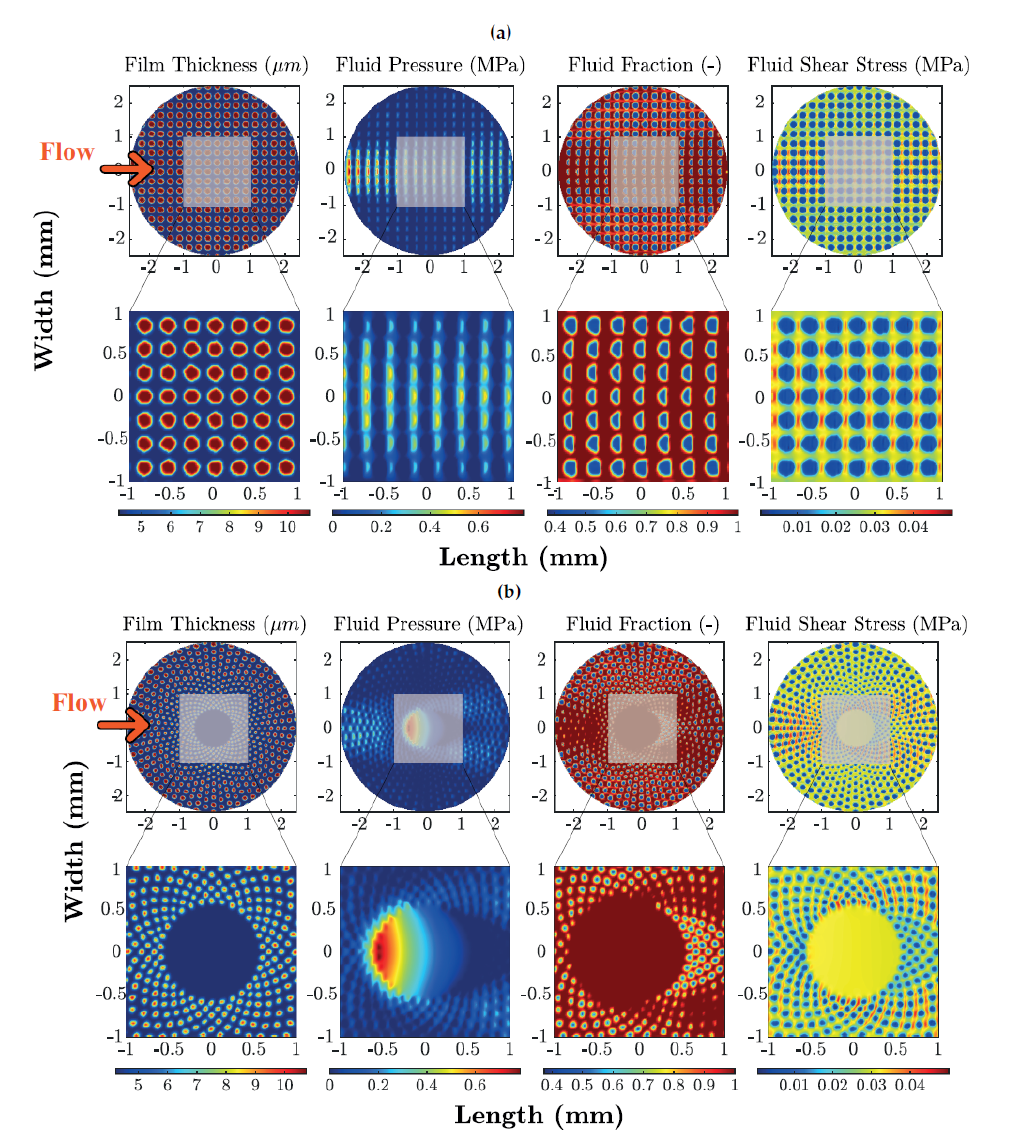
Figure 10. Contour plots for film thickness, fluid pressure, fluid fraction and average shear stress. Results, obtained by means of FV numerical simulations, refer to a Hersey number equal to η U / P av = 2.35 × 10 − 6 —( a ) Uniform texture (44%), ( b ) Sunflower